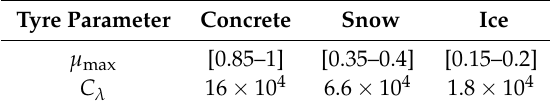
Table 3. Longitudinal stiffness C λ values obtained in